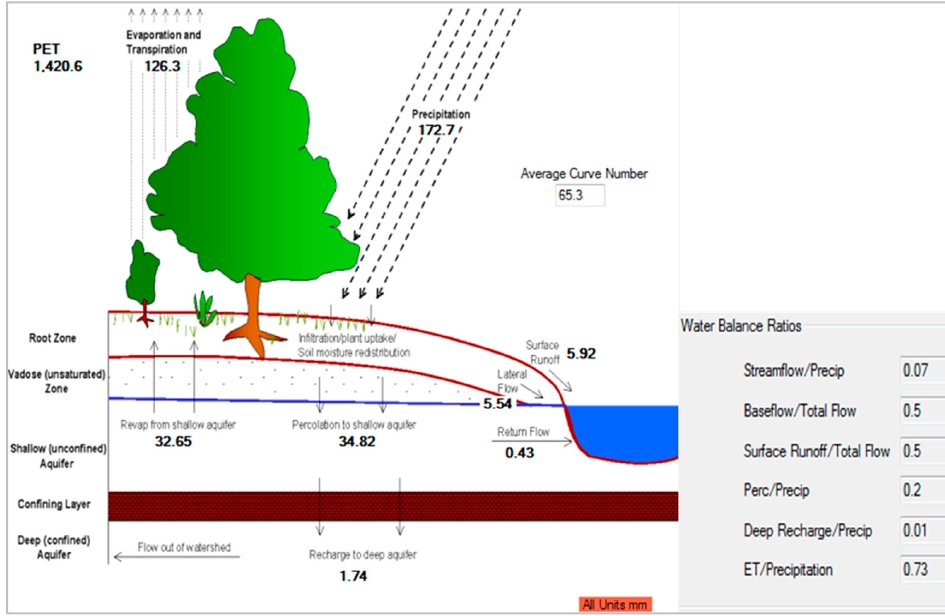
Figure 4. Simulated hydrology and water balance ratios for AZB for the manual calibration period (1973–2015).